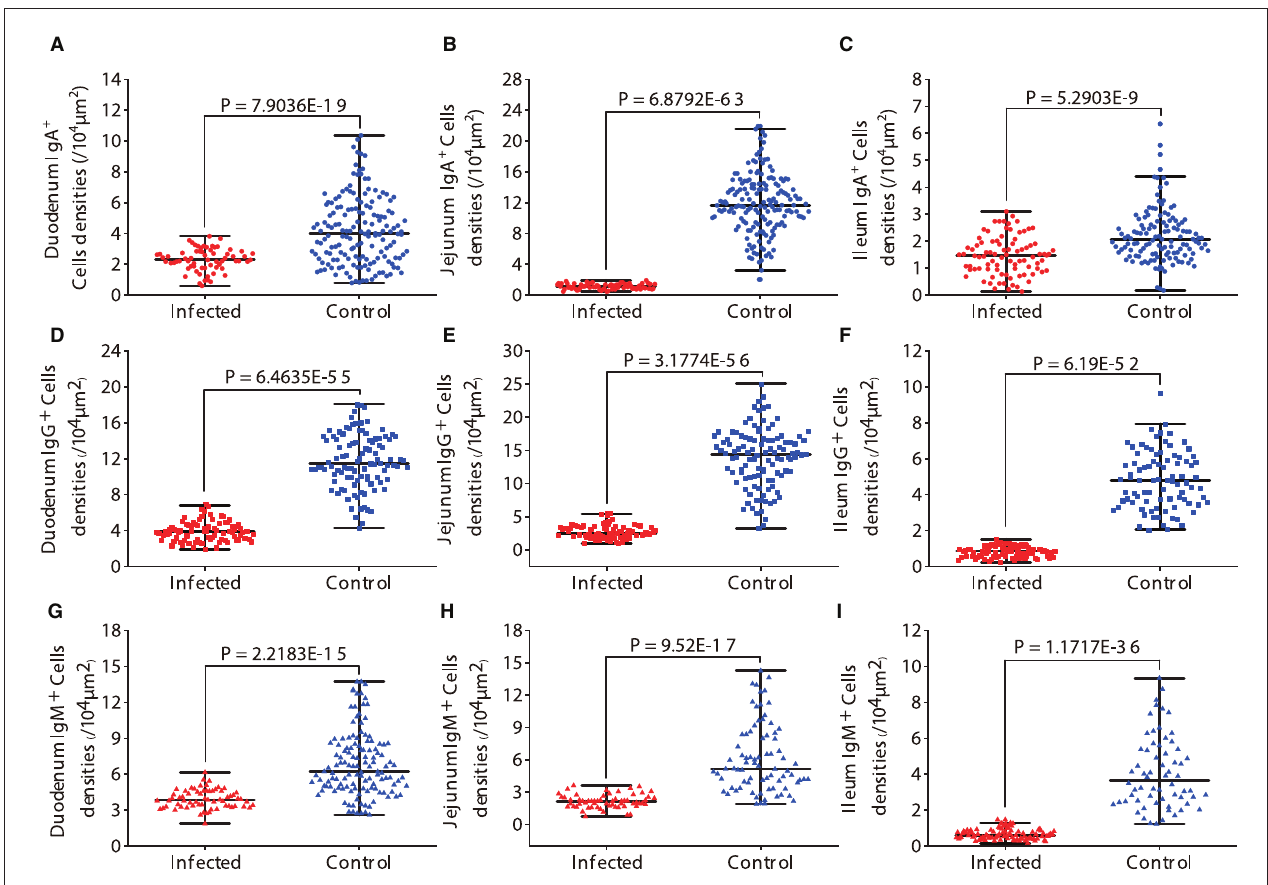
FIGURE 13 | The impact of Moniezia benedeni infection on the distribution of IgA + , IgG + , and IgM + cells in the small intestine of sheep. (A–C) The impact of Moniezia benedeni infection on IgA + cells density; (D–F) The impact of Moniezia benedeni infection on IgG + cells density; (G–I) The impact of Moniezia benedeni infection on IgM + cells density. P < 0.05 means significant